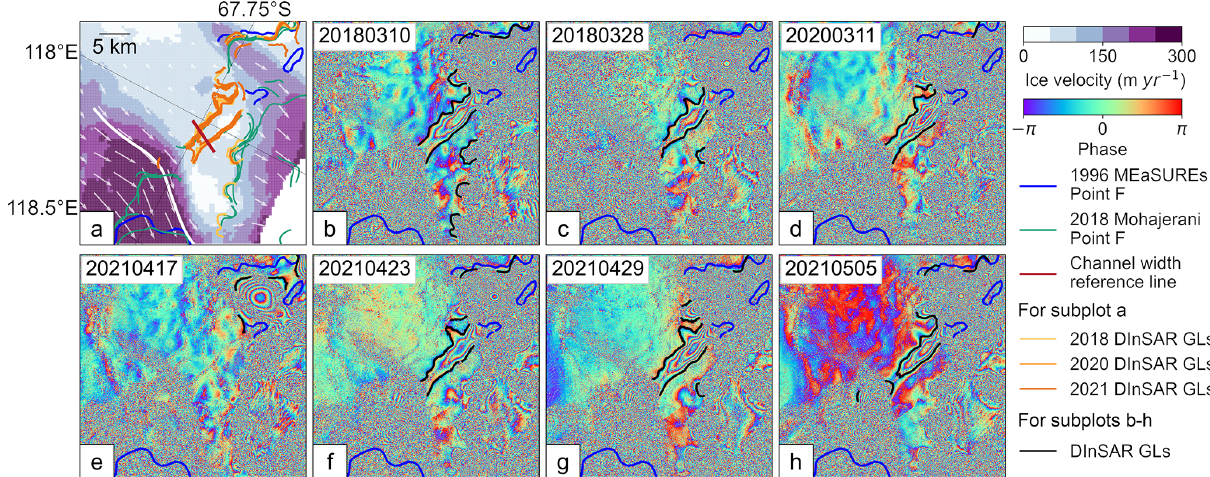
Figure 8. (a) Distribution of different grounding line (GL) products at Moscow University Western Ice Shelf (MUWIS) ocean channel overlaid with the ice surface velocity magnitudes (Rignot et al., 2017) and ice flow directions (white arrows). The reference line for measuring channel width is shown as the red solid line. The Sentinel-1a/b DInSAR GLs mapped in this study are colour-coded by year. (b–h) GLs (black solid lines) delineated from the Sentinel-1a/b DInSAR interferograms between 2018 and 2021 in this study. In all subplots, the 1996 DInSAR- derived GLs (Rignot et al., 2011, 2016) are shown as blue solid lines. The ice flowline used to measure the GL migration rates is shown as the white solid line, and the 2018 DInSAR-derived GLs (Mohajerani et al., 2021) are shown as green solid lines in panel (a) .